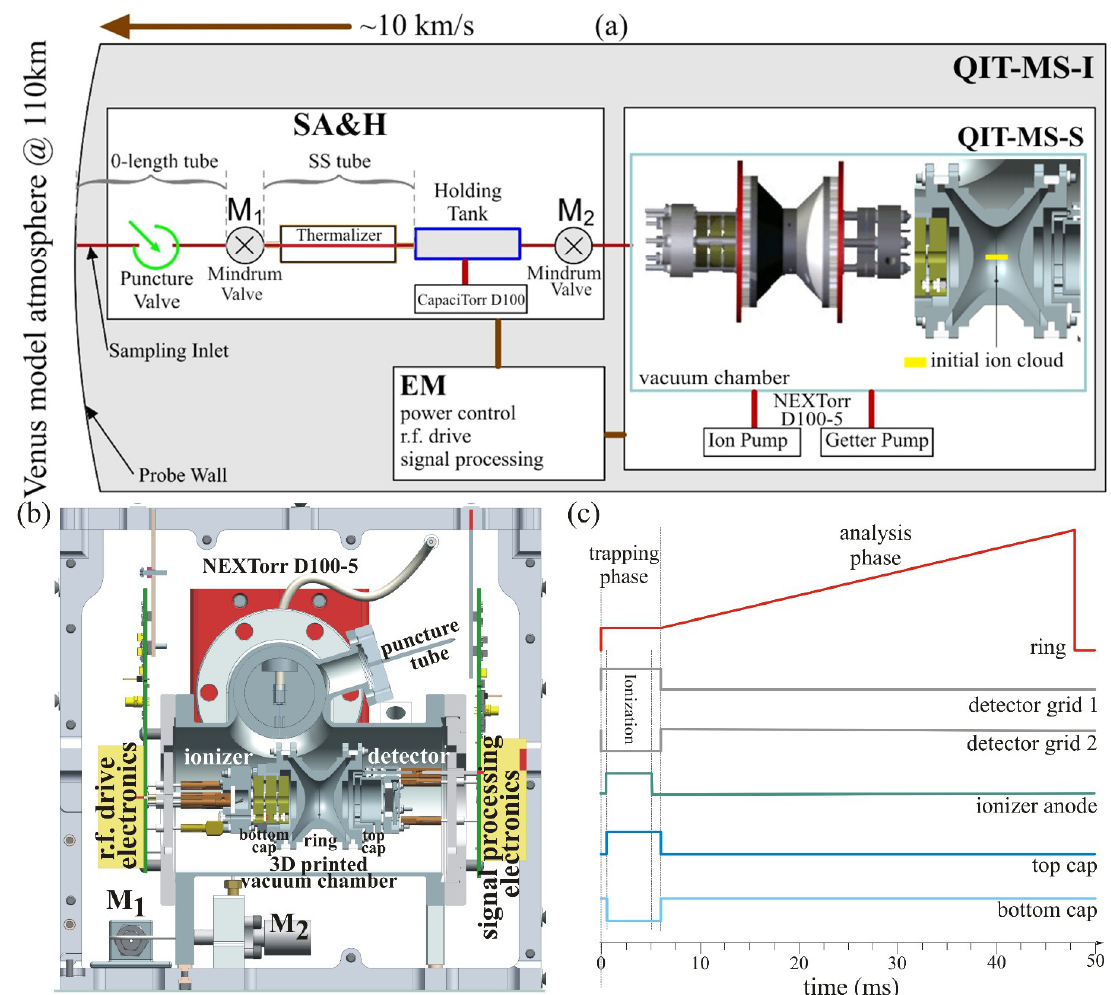
Figure 1. ( a ) The schematic of QIT‐MS‐I (Quadrupole Ion Trap Mass Spectrometer